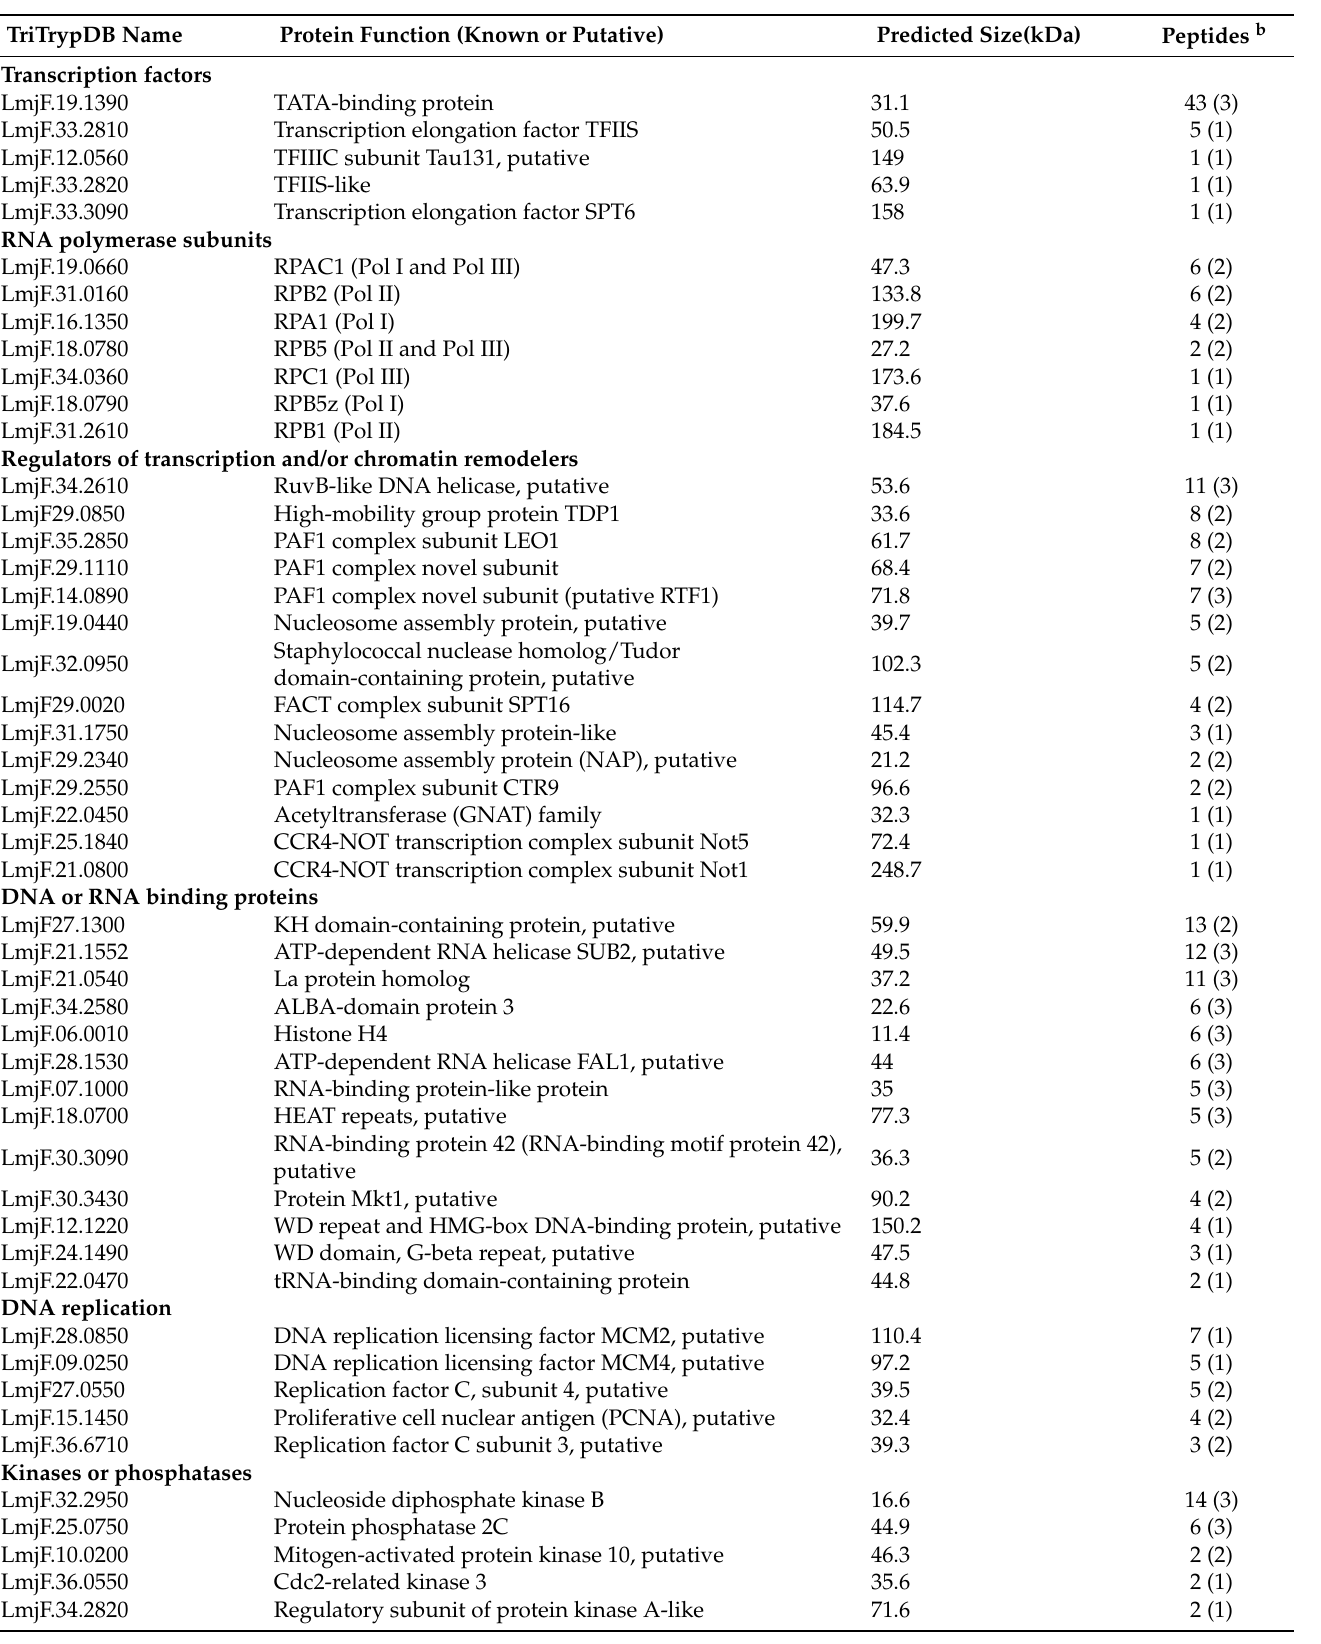
Table 1. Proteins that co-purified with LmBrf1 a